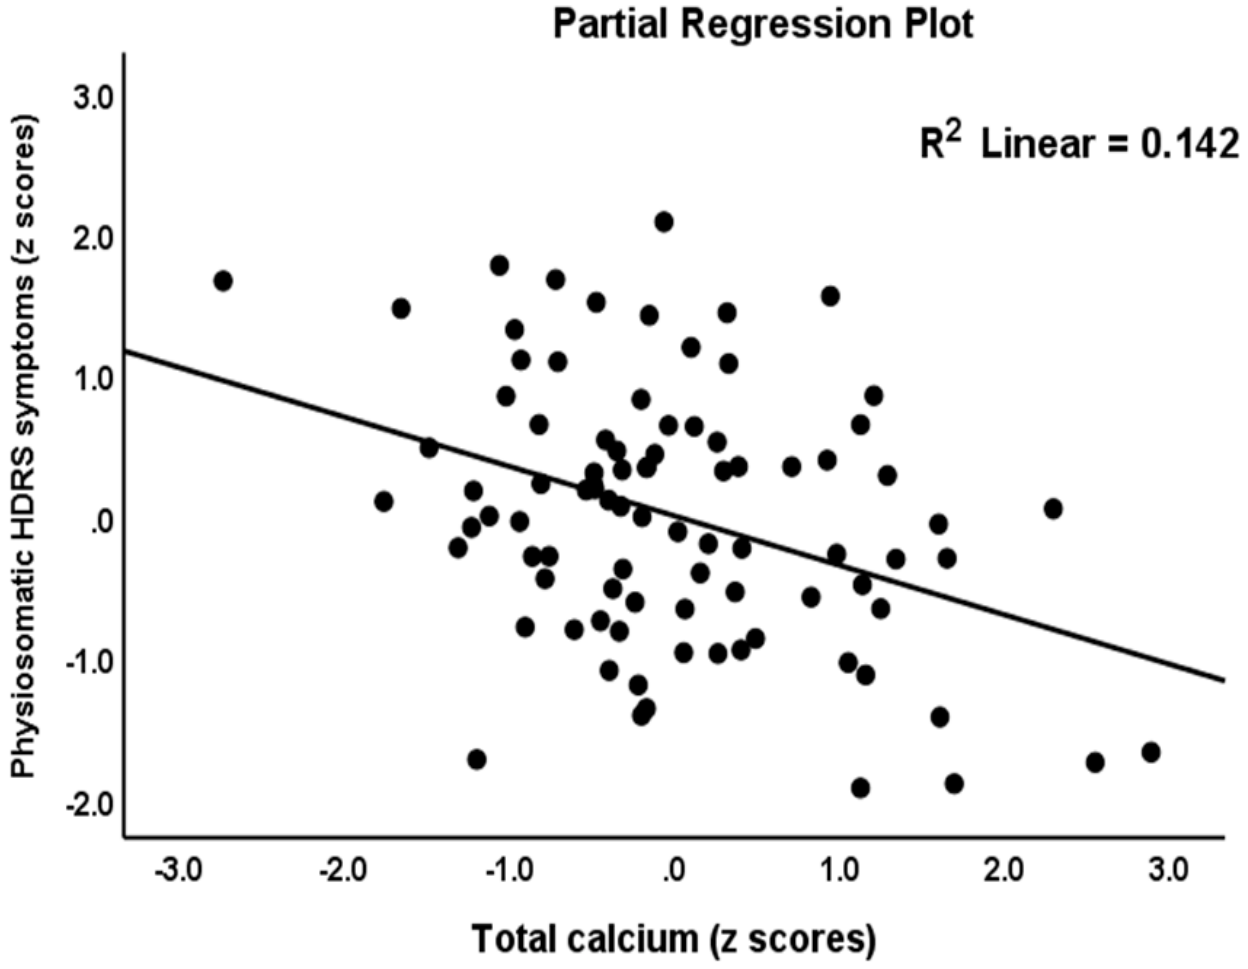
Figure 2. Partial regression plot with the physiosomatic component of the Hamilton Depression Score (HDRS) as dependent variable and total calcium as explanatory variable.